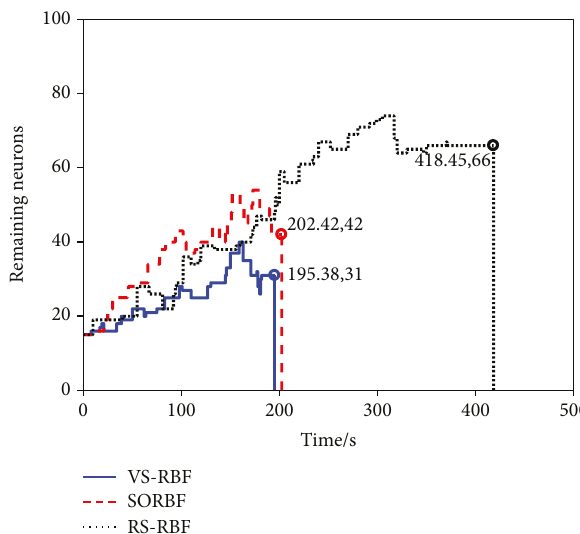
Figure 12: Number of remaining neurons during training.